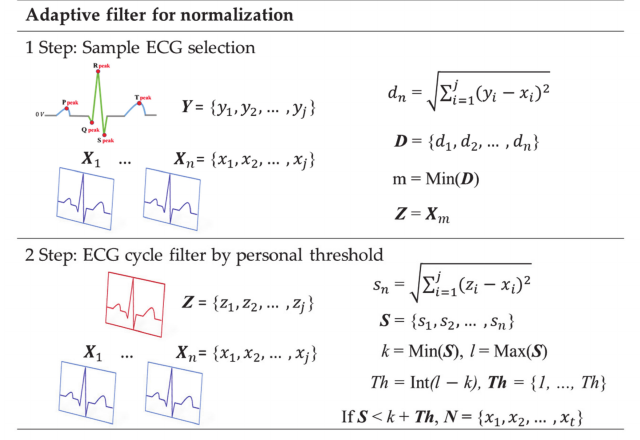
Figure 7. Adaptive filter process for